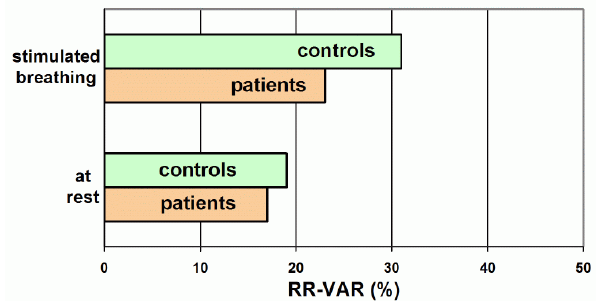
Fig.3: Variability in RR-interval (RR-VAR) in the group of patients suffering from Parkinson’s disease and in the control group, during normal breathing at rest and during stimulated, deep breathing. At rest there is no significant difference between the two groups. During stimulated deep breathing RR-VAR increased significantly within both groups. However, this increase was significantly less in the patient group.